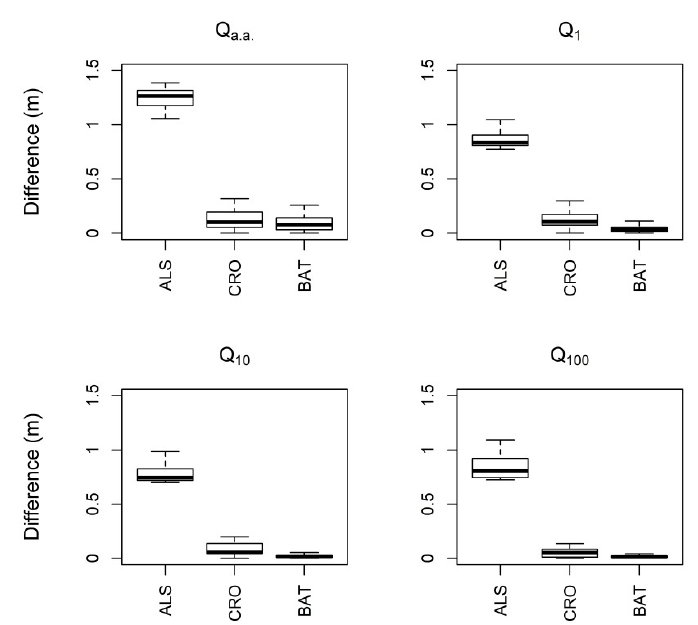
Figure 9. Variance of raster cell differences in water surface elevation between the compared digital elevation models (ALS, CRO, BAT) and the reference model (ADP).